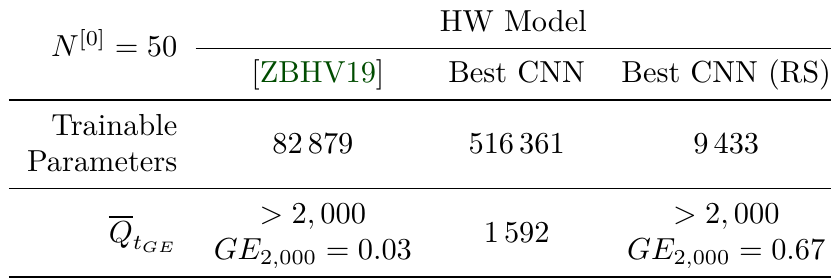
Table 7: Comparison of the top generated CNNs for the ASCAD N [0] = 50 HW model experiments with the current state-of-the-art.